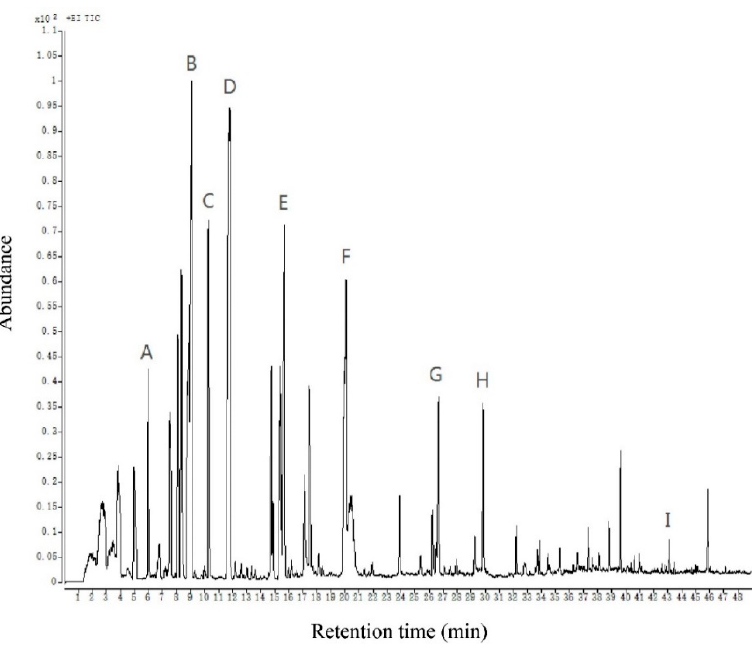
Figure 2. The total ion chromatogram of volatile compounds of Chinese chive. All volatiles detected are listed in Table 1. The letters A – I are part of the volatile compounds of Chinese chive corresponding to the peaks. ( A ) 2-methylpent-4-enal; ( B ) allyl methyl disulfide; ( C ) 2,5-octanedione; ( D ) dimethyl trisulfide; ( E ) diallyl disulfide; ( F ) methyl allyl trisulfide; ( G ) 3-ethenyl-3,6-dihydrodithiine; ( H ) diallyl trisulfide; ( I) 2,4-di-tert-butylphenol.